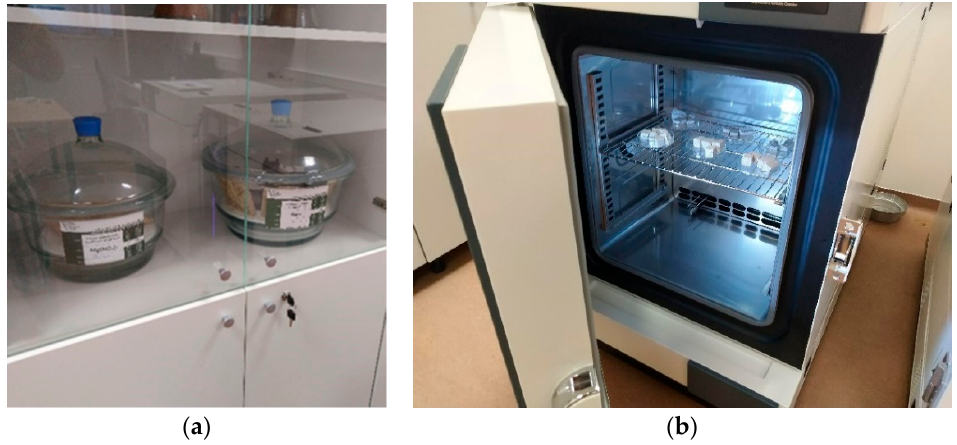
Figure 2. ( a ) Rack with desiccators in an airconditioned room; ( b ) samples in an environmental chamber. Table 2. Mixing ratio for sulfuric acid and demineralized